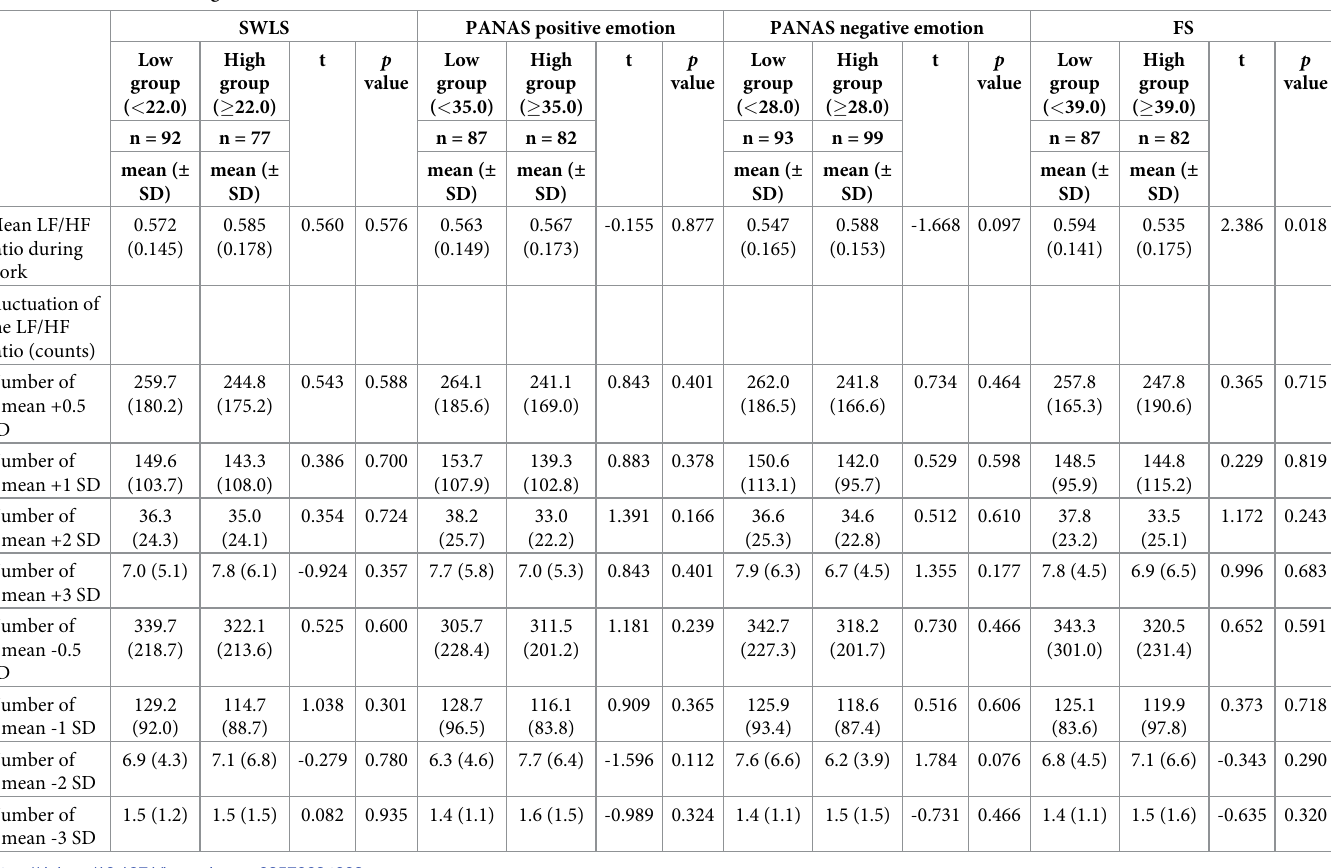
Table 2. LF/HF ratio during work and fluctuation in the LF/HF